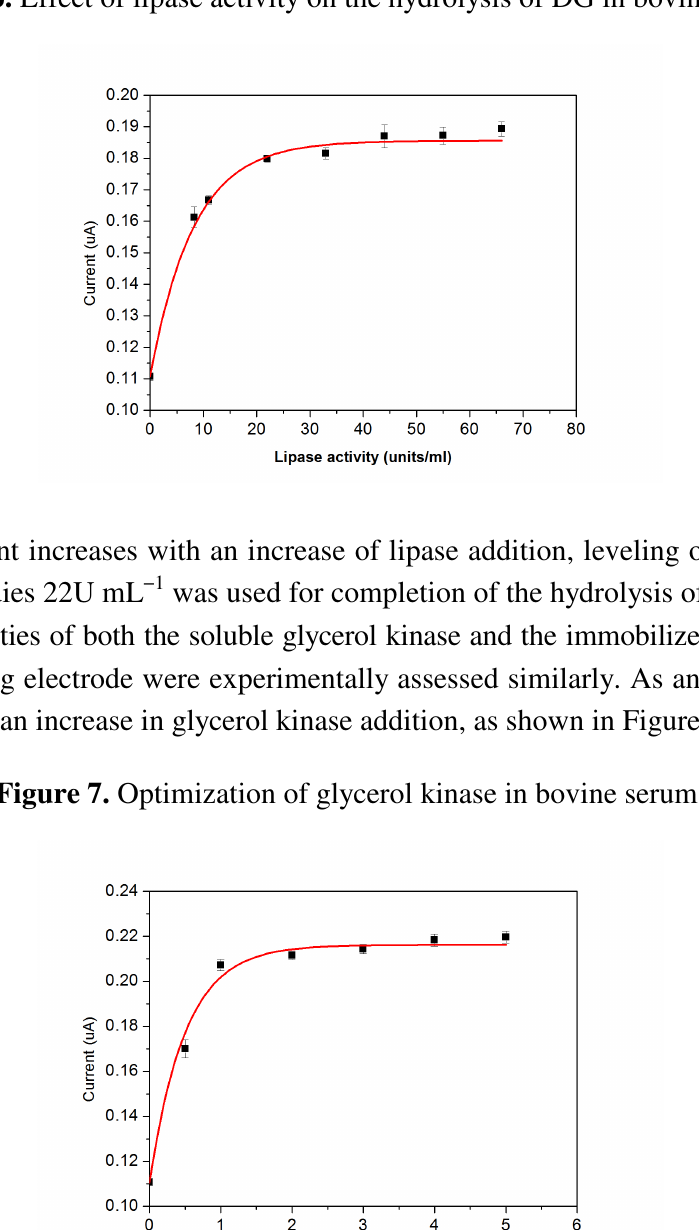
Figure 6. Effect of lipase activity on the hydrolysis of DG in bovine serum.